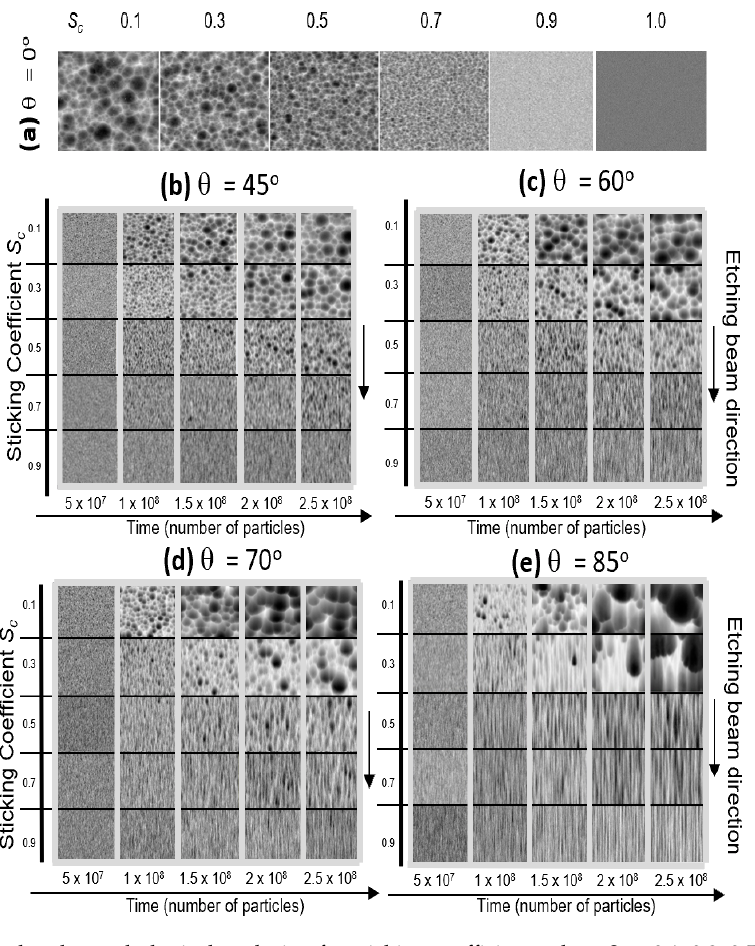
Figure 2. Simulated morphological evolution for sticking coefficient values S c = 0.1, 0.3, 0.5, 0.7 and 0.9 at OAE etching angles ( a ) θ = 0°, ( b ) 45°, ( c ) 60°, ( d ) 70°, ( e ) 85°. Coatings 2018 , 8 , x FOR PEER REVIEW